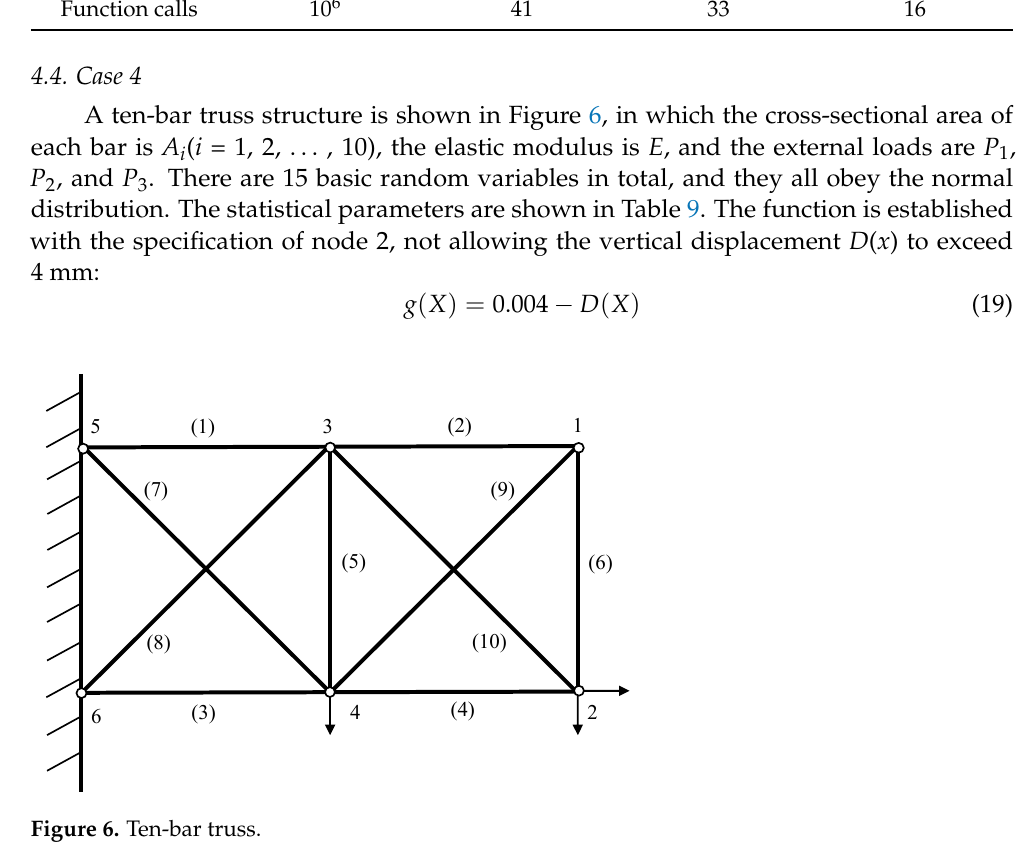
Table 8. Comparison of calculation results of Case 3.